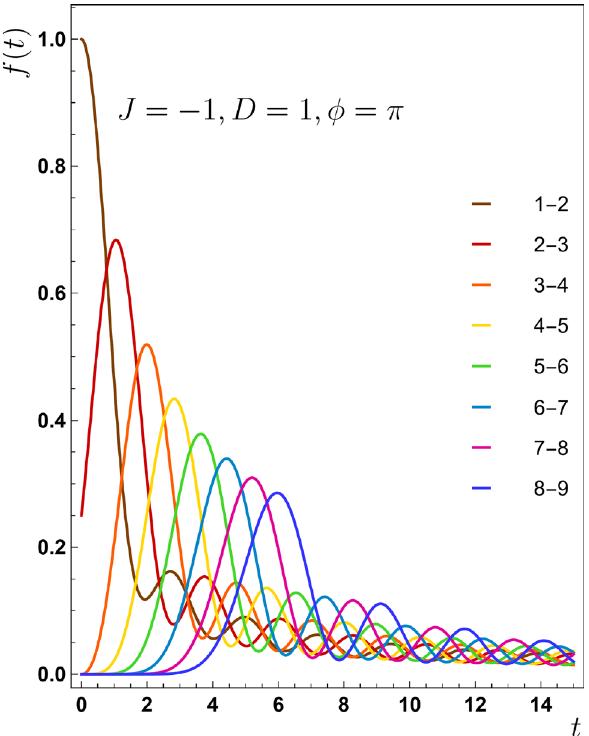
Figure 6. Fidelity for various pairs to ensure that entanglement transmission is according to